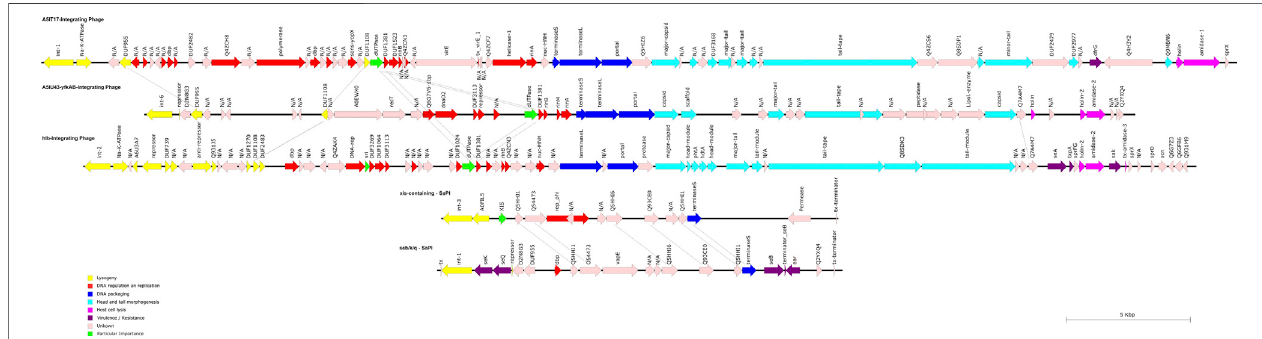
FIGURE5| Schematicrepresentation ofthethreeSiphoviridae phagesandthetwoSaPIsofRGB-095930. Thedirections,lengths,andpositionsofalignedgenes (see also Supplementary Tables S2 – S6 ) are shown by arrows. The colours represent the typical functional modules of S. aureus Siphoviridae: Lysogeny, DNA regulation und replication, DNA packaging, head and tail morphogenesis, and host cell lysis. Potential virulence factors are usually located downstream of the lysis module or, less commonly, inserted between lysogenesis and DNA metabolism (Deghorain and Van Melderen, 2012).